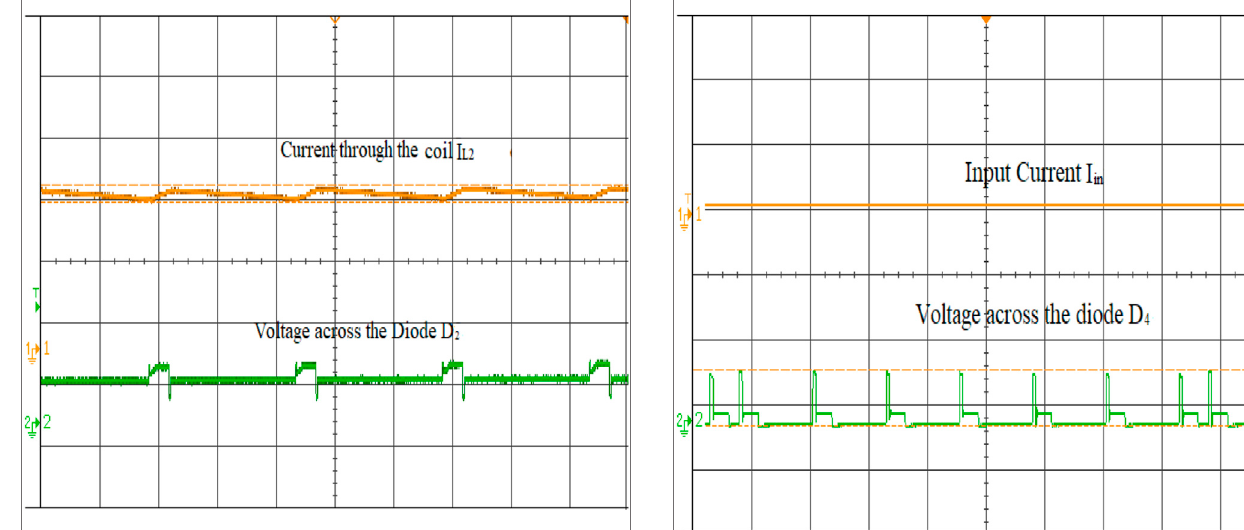
FIGURE 15 | Input Current Iin and Diode Voltage D 4 .